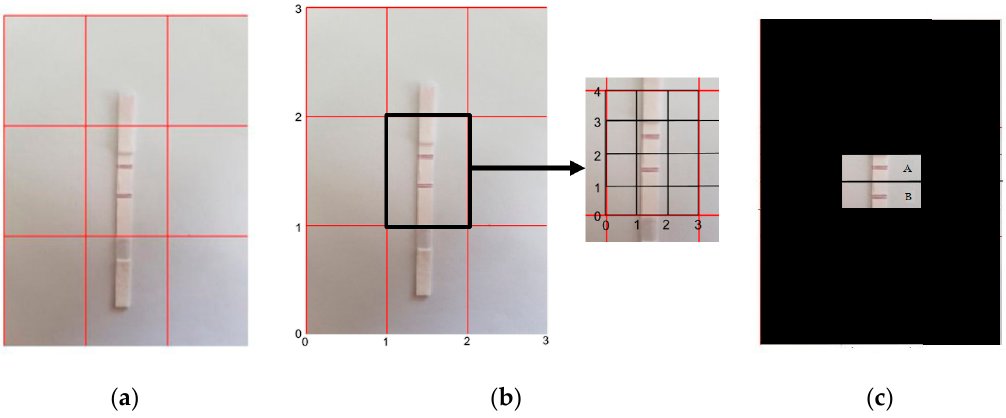
Figure 4. ( a ) A 3 × 3 grid of the smartphone camera view with proper positioning of LFA, ( b ) dimension extraction of regions from the center box ((1, 1), (2, 1), (1, 2), (2, 2)), with the test line and the control line position indexes ((0, 1), (3, 1), (0, 2), (3, 2)) and ((0, 2), (3, 2), (0, 3), (3, 3)), respectively, and ( c ) the control line and the test line regions (marked as A and B, respectively).